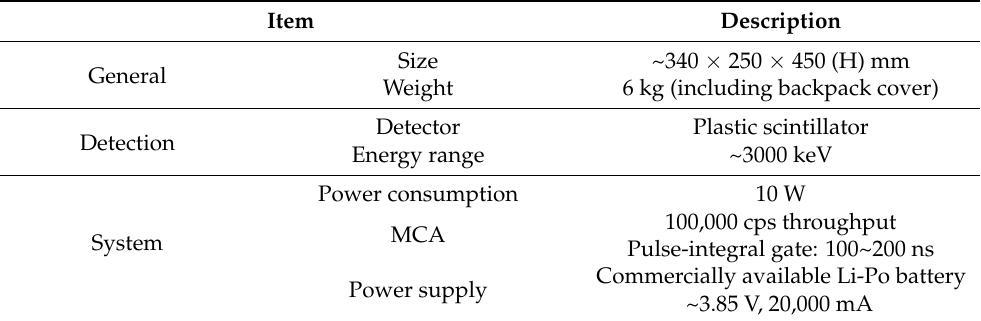
Figure 6. Plastic scintillator-based wireless radiation measurement system. ( a ) Configuration of backpack-typed wireless system. ( b ) Components of plastic detection system and connection diagram. Table 1. Detailed specifications of the backpack system.